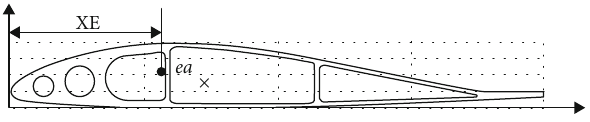
Figure 6: Blade section.